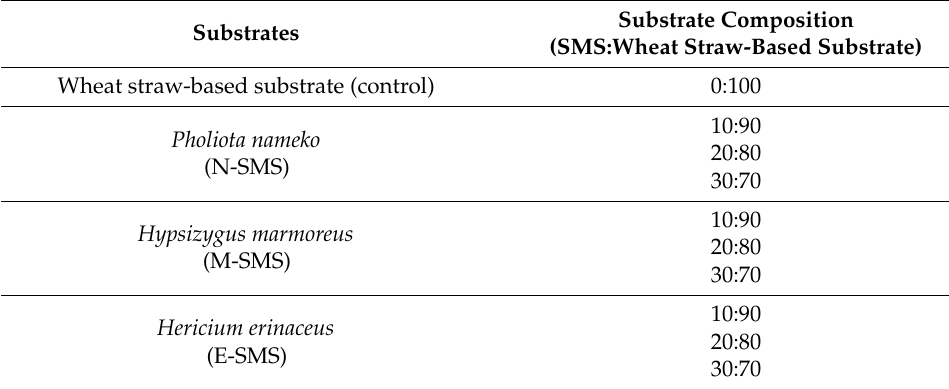
Substrate Composition (SMS:Wheat Straw-Based Substrate)